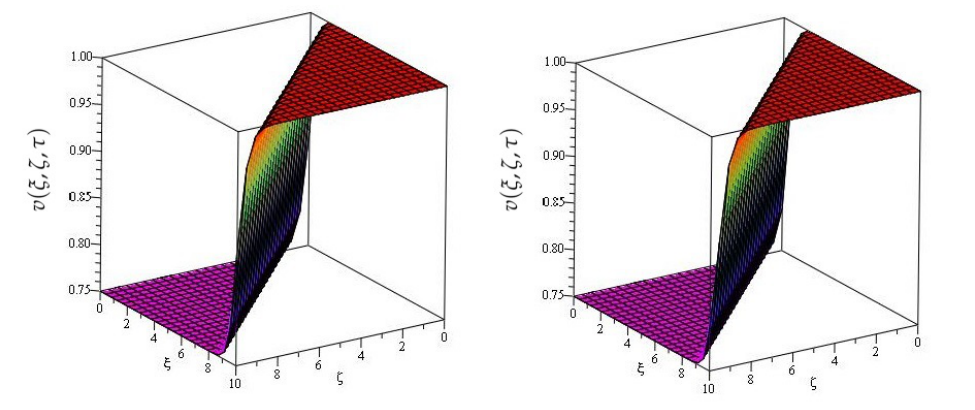
Figure 5. The numerical solution graph of v ( ξ , ζ , τ ) of Example 1 at β = 0.8 and